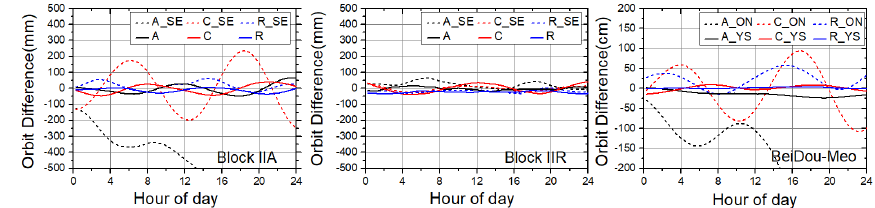
Figure 2. Orbit differences between predicted orbits and precise ephemerides in inertial space after Helmert frame transformation for Block-IIA (G32, left ), Block-IIR (G11, middle ) and BeiDou-MEO (medium earth orbit) (C12, right ) satellites. A, C and R represent along-track, cross-track and radial direction on solar visible day, respectively. A_SE, C_SE and R_SE represent along-track, cross-track and radial direction on solar eclipse day, respectively. ON and YS represent orbit-normal and yaw-steering modes, respectively.